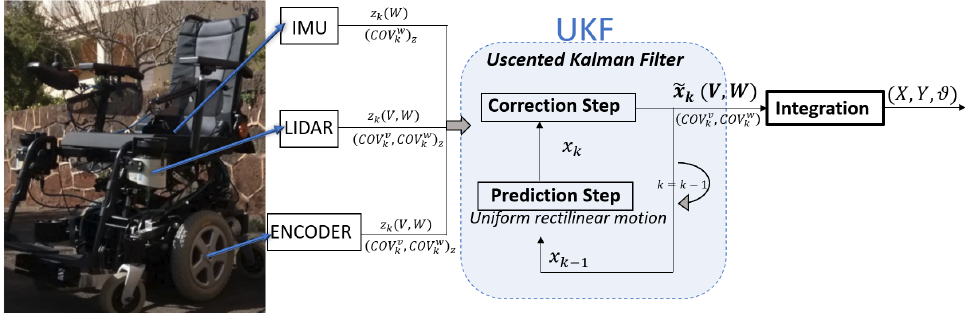
Figure 1. The localization system proposed for the